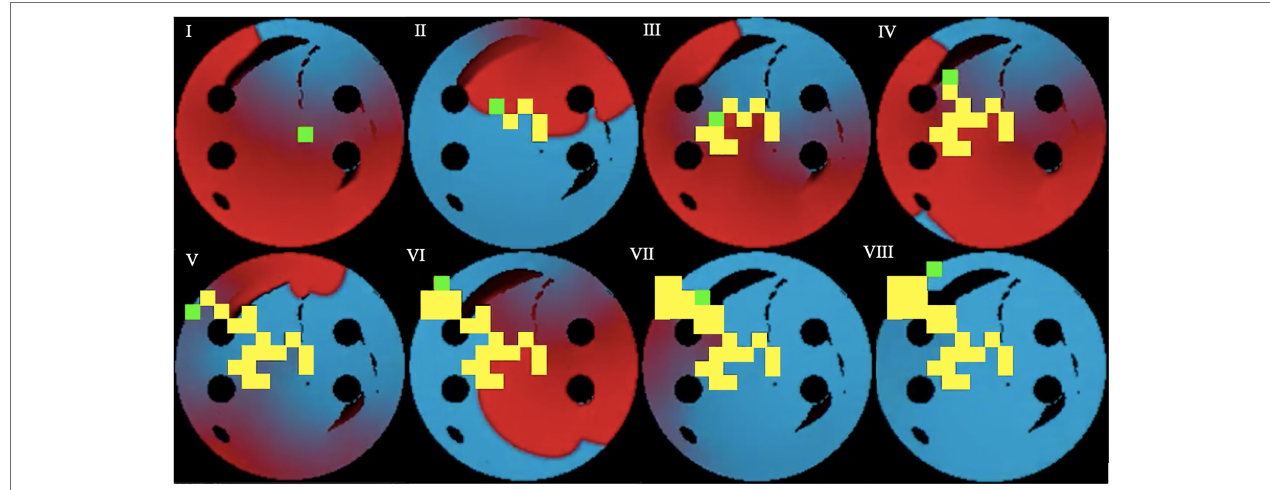
FIGURE 6 | Testing sequence, where the ablator (green) uses the pre-existing model and Q-values from training to successfully terminate the rotor. Same colour code is used as in Figure 5 . Voltage distributions in consecutive moments of time are shown in (I)–(VIII) .